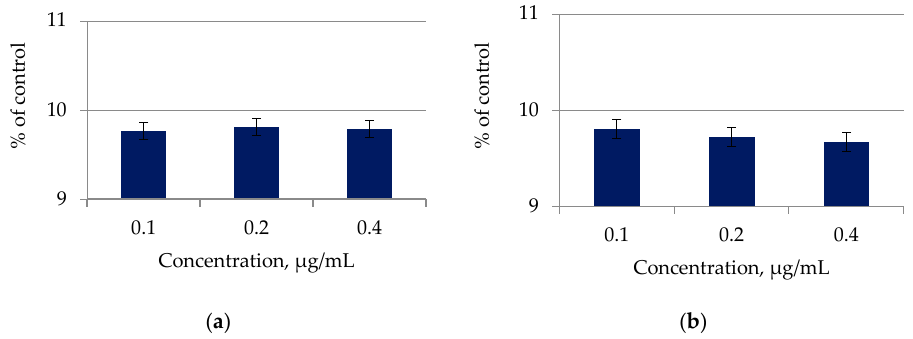
Figure 5. Effect of lipid complexes of microalgae ( a ) C. vulgaris and ( b ) A. platensis on the skin melanoma cell line SK-MEL-2 after 48 h of incubation.